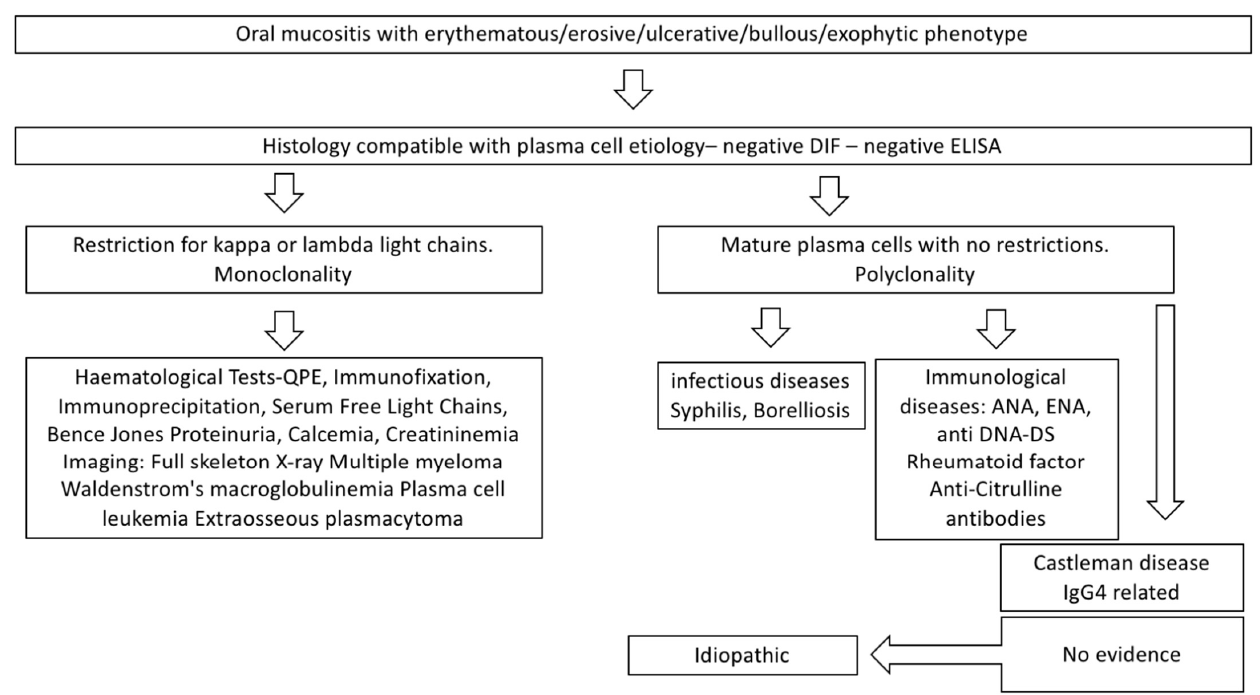
Figure 5. Diagnostic pathway for o-PCM.